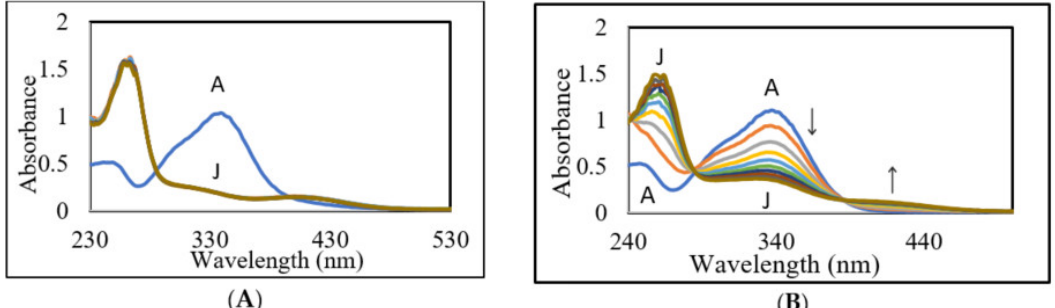
Figure 3. Oxidation of DBL catechol by sodium periodate in ( A ) sodium phosphate buffer, pH 7.0 and ( B ) 0.2 M acetic acid. A reaction mixture (1 mL) containing DBL catechol and equimolar amounts of sodium periodate in ( A ) 50 mM sodium phosphate, pH 7.0 or ( B ) 0.2 M acetic acid was incubated at room temperature and the absorbance changes occurring at UV and the visible region were followed using a spectrophotometer at 6 s intervals. The reaction occurred very fast and seems to have reached completion in about 6 s. Scan A, start of the reaction; Scan J, 54 s reaction.